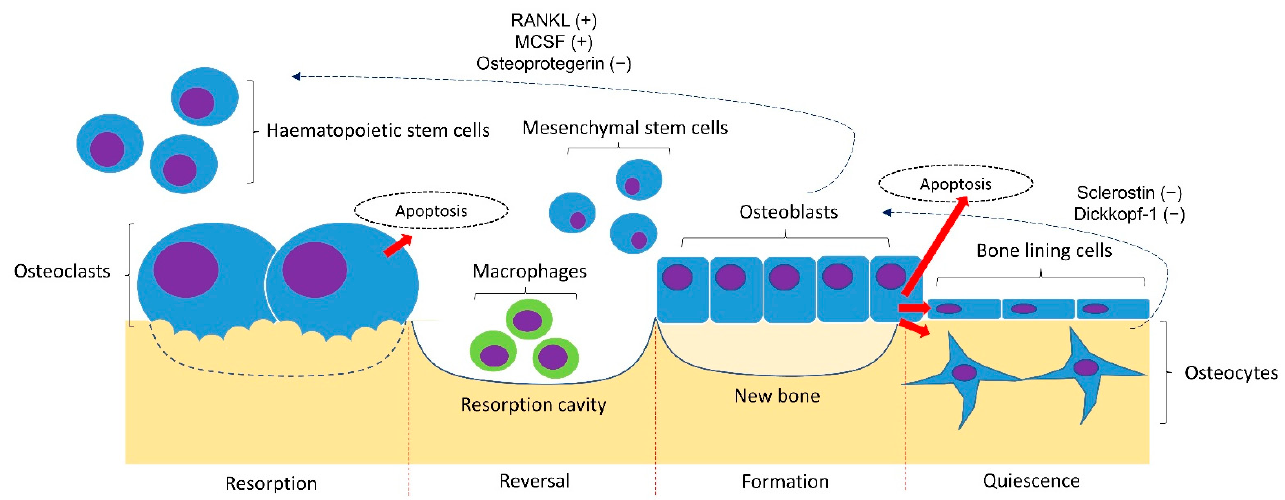
Figure 1. Bone remodelling cycle. The bone remodelling cycle is governed by osteoclasts, osteoblasts and osteocytes derived from the respective stem cell lineage. The differentiation of osteoclasts is stimulated by the receptor activator of nuclear factor kappa-B ligand (RANKL) and macrophage colony-stimulating factor (MSCF) and inhibited by osteoprotegerin (OPG) synthesised by osteoblasts and osteocytes. The osteogenesis of osteoblasts is inhibited by sclerostin and Dickkopf-1 synthesised by osteoblasts. Notes: +, promoting factor; − , inhibiting factor.